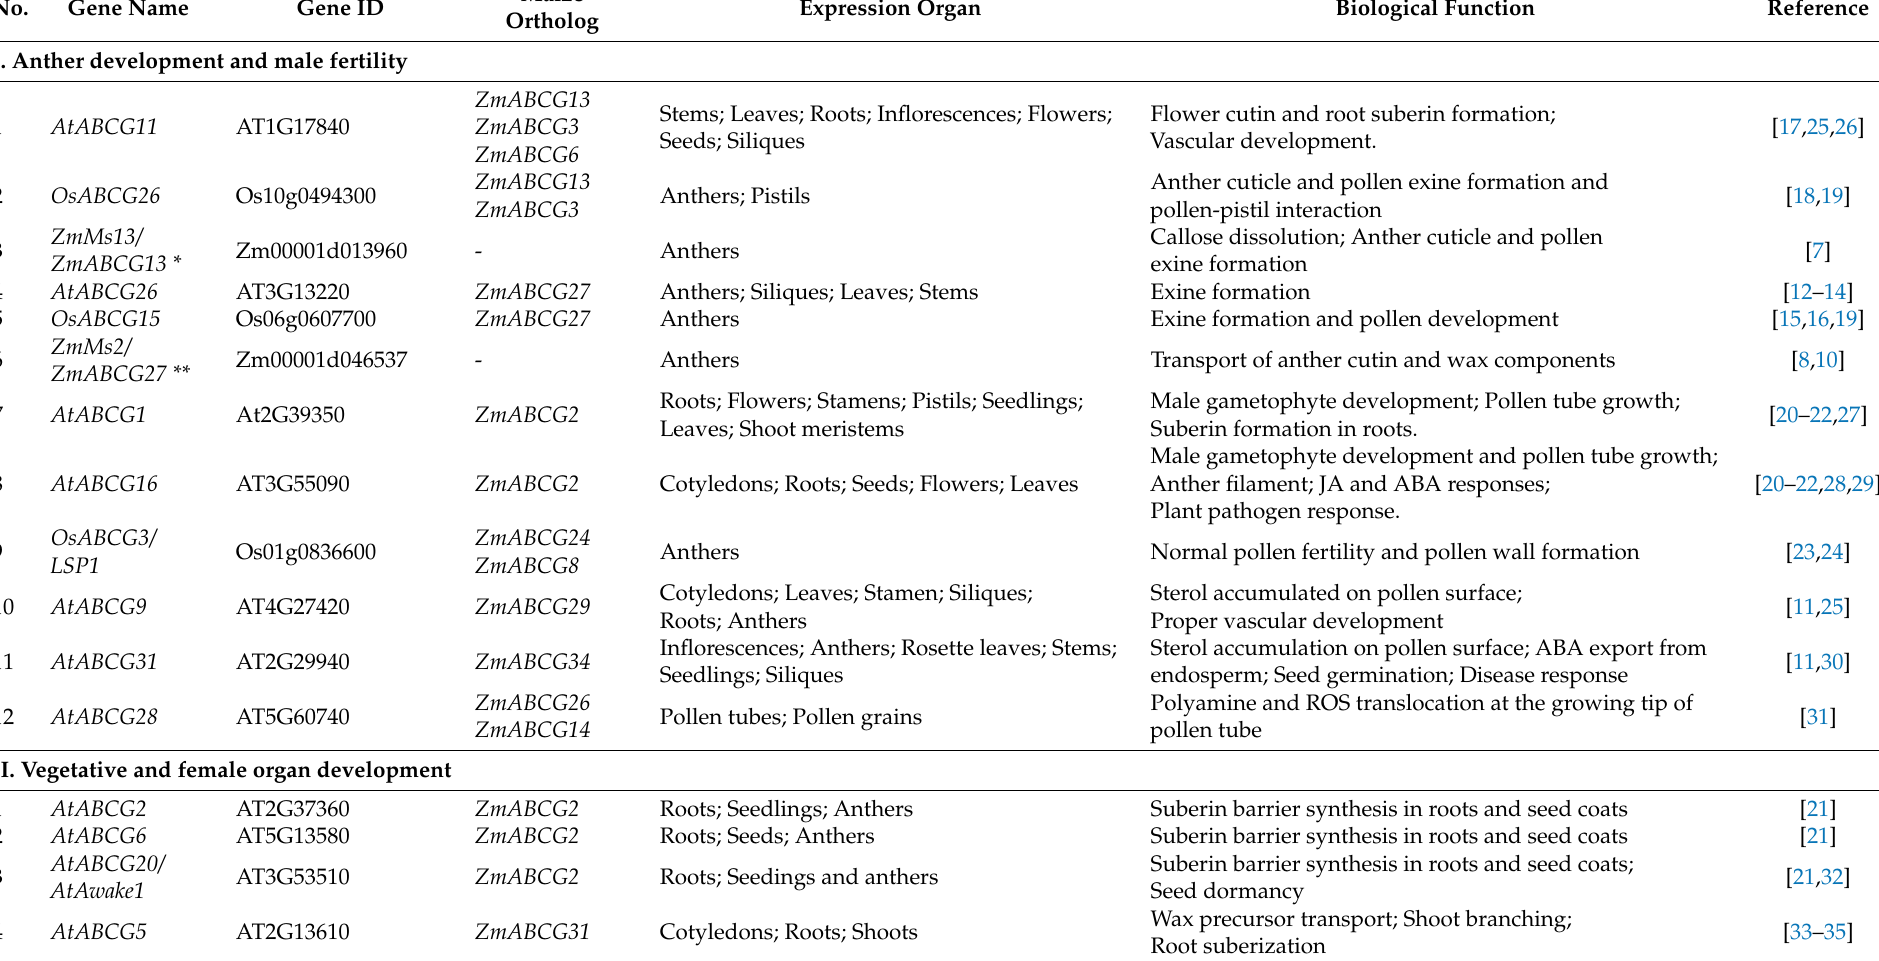
Table 2. Functional Classifications of The Reported ABCG Genes in Arabidopsis , Rice and Their Orthologs in